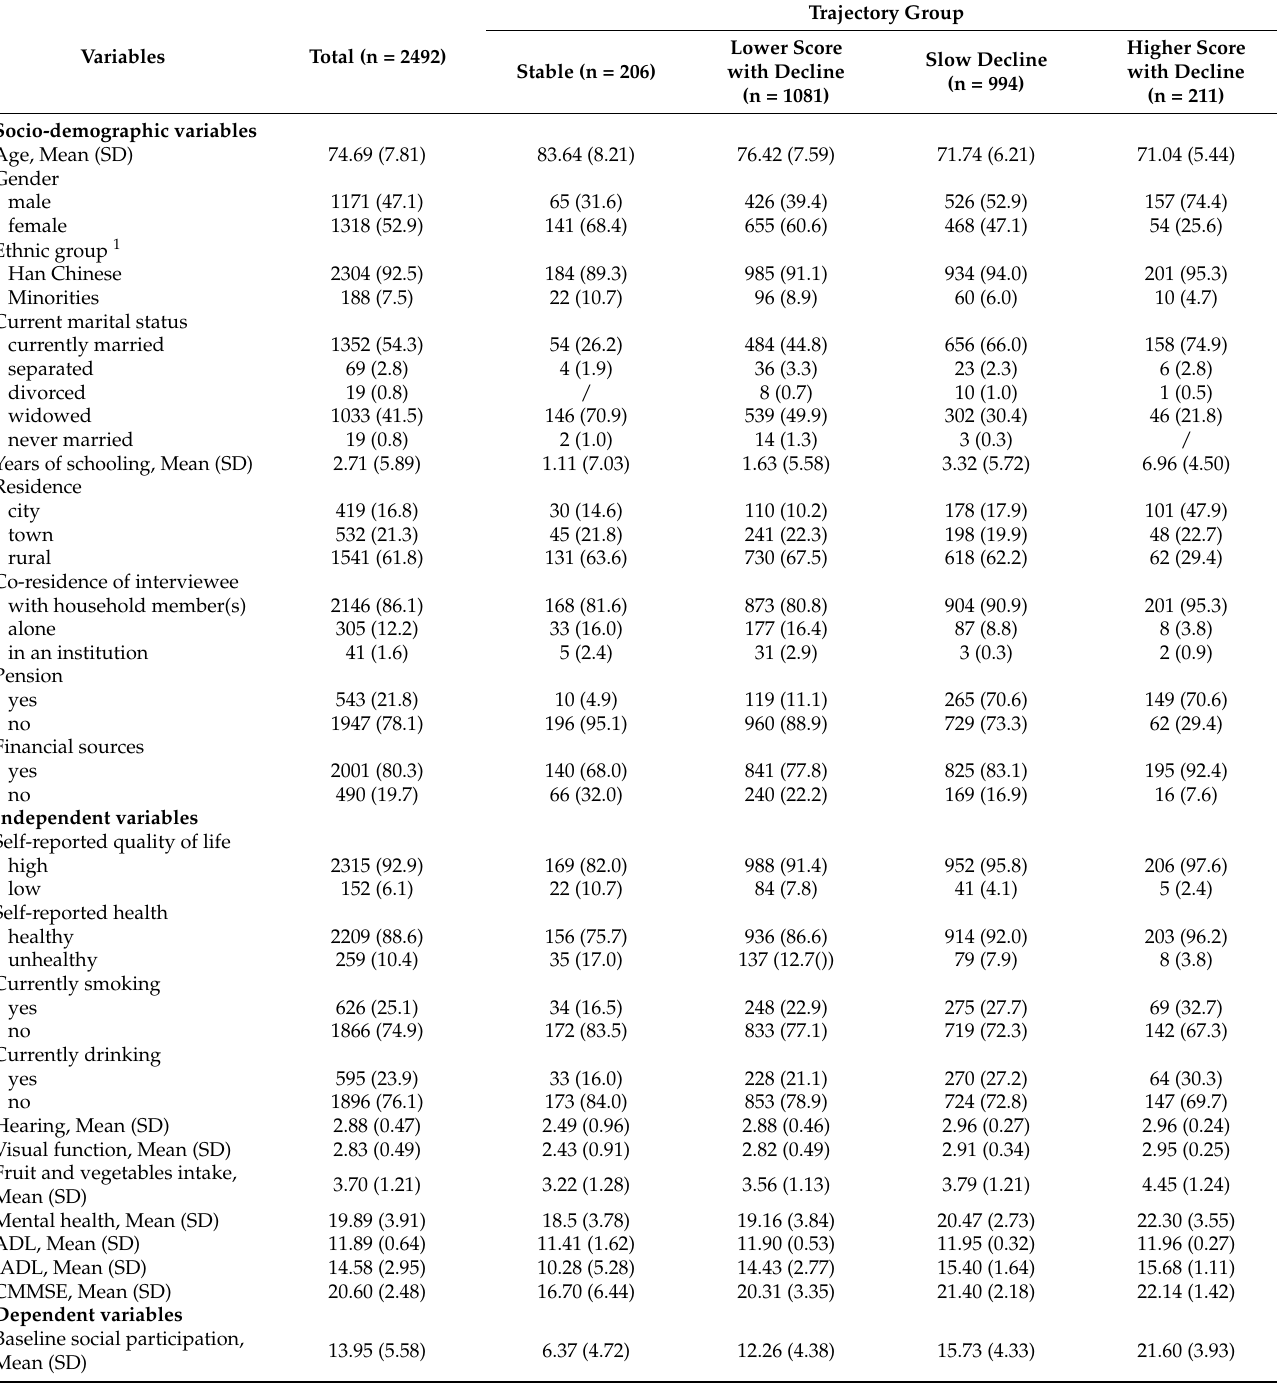
Table 2. Baseline characteristics of the total sample and the sample by different trajectory